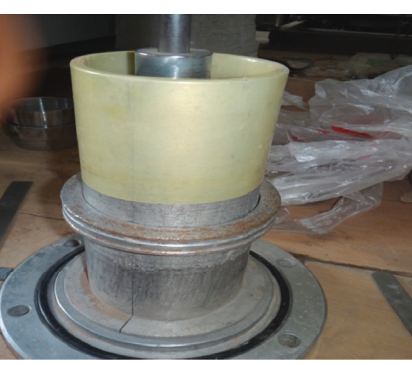
Figure 4: Special sample kit for medium-scale triaxial experiments.